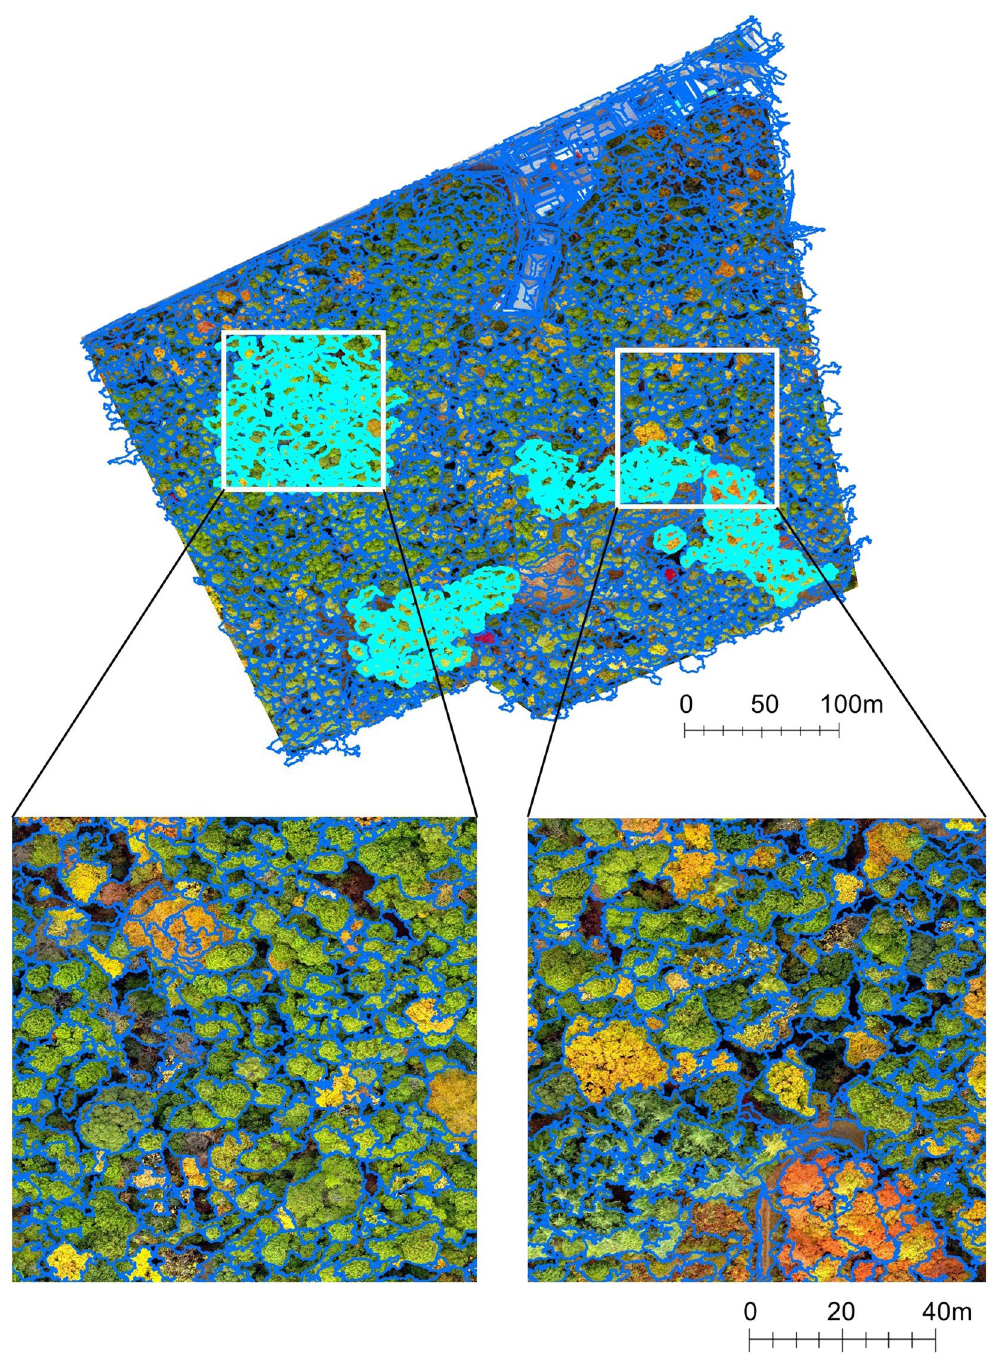
Figure 2. Whole area and representative enlarged tree crown map. The blue line show grid-line of segmented polygons. The white rectangle shows the location of enlarged area, and light blue polygons are used for evaluating the accuracy of tree segmentation. This map was constructed via multiresolution segmentation using colour, DSM, and Slope model. This figure was created using ArcGIS Desktop v10.6 software (https ://www.esri. com, Environmental Systems Research Institute, Inc., Redlands, United